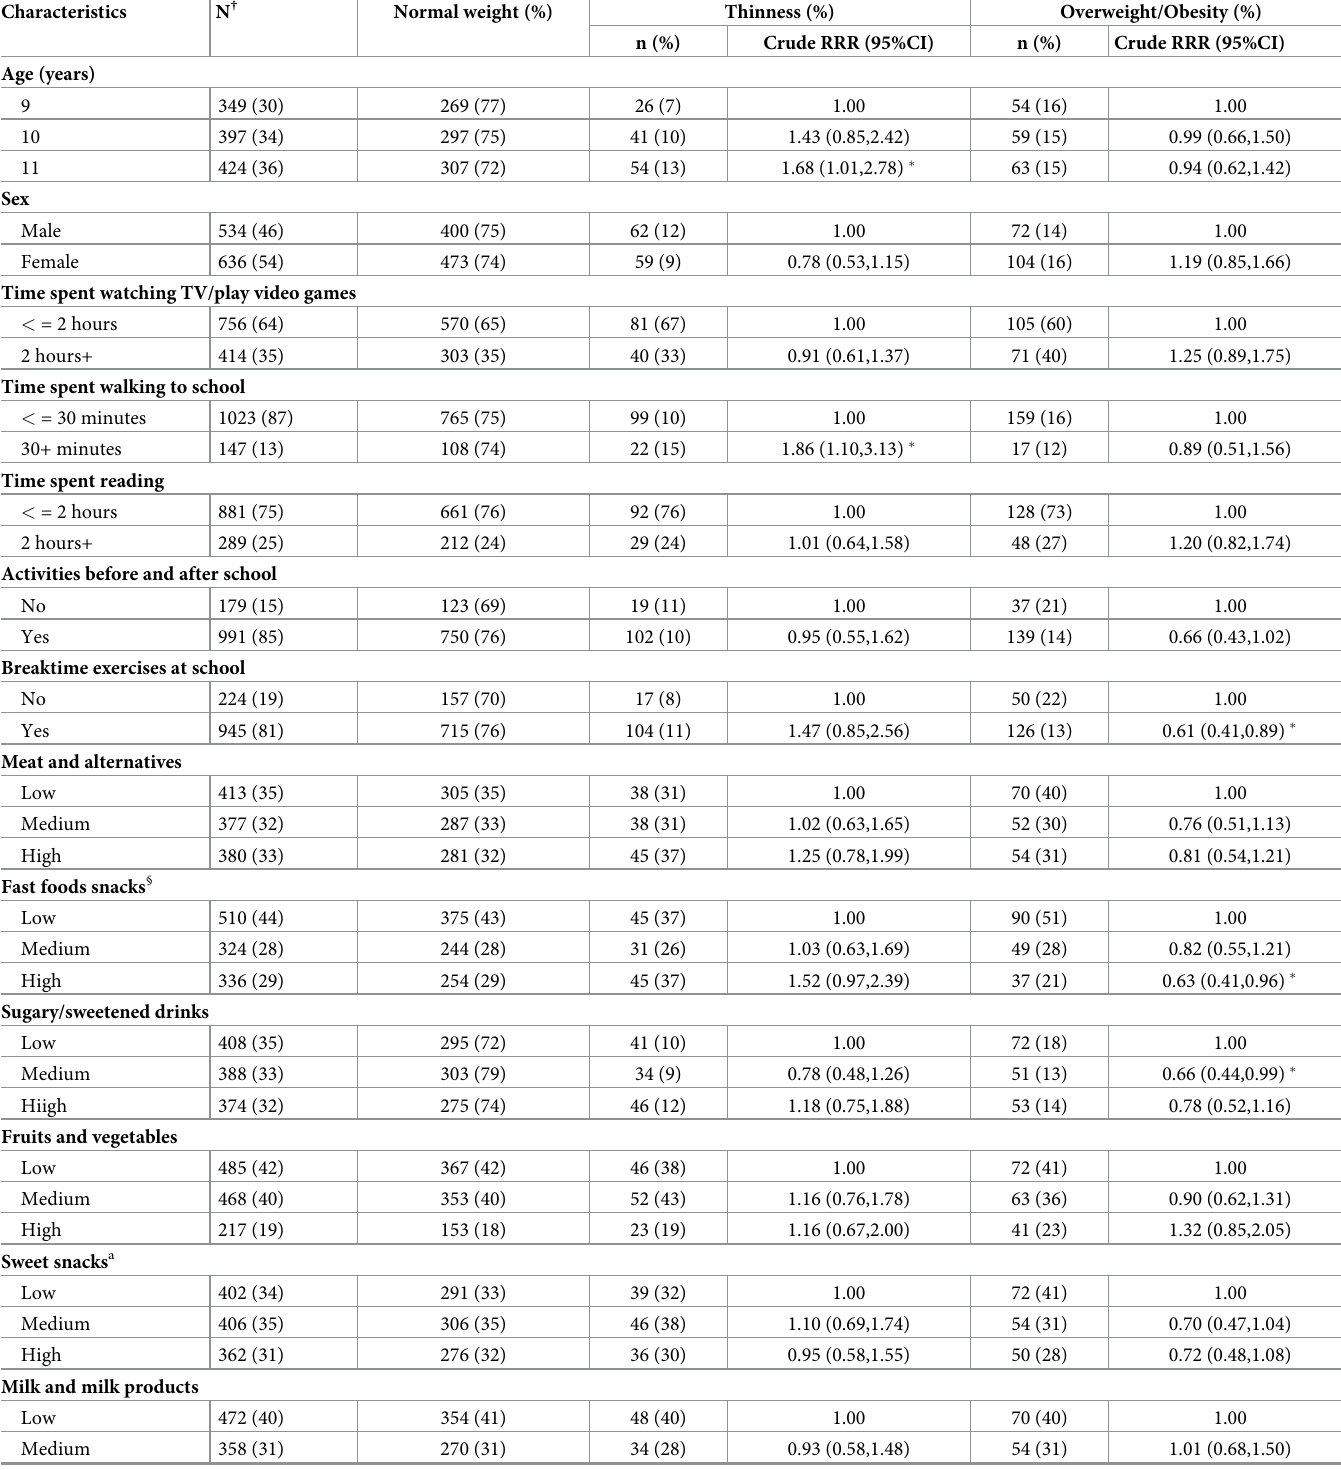
Table 1. Child demographic, physical activity and dietary behavior correlates for overweight and obesity (N = 1170).